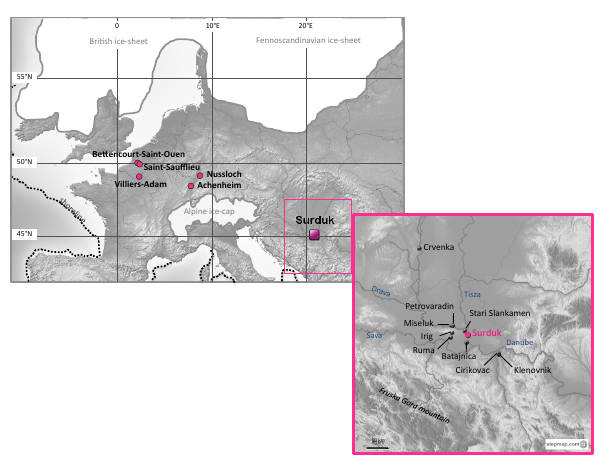
Fig. 1. Location of the Surduk loess sequence. Other series relevant to this study and mentioned in text are also